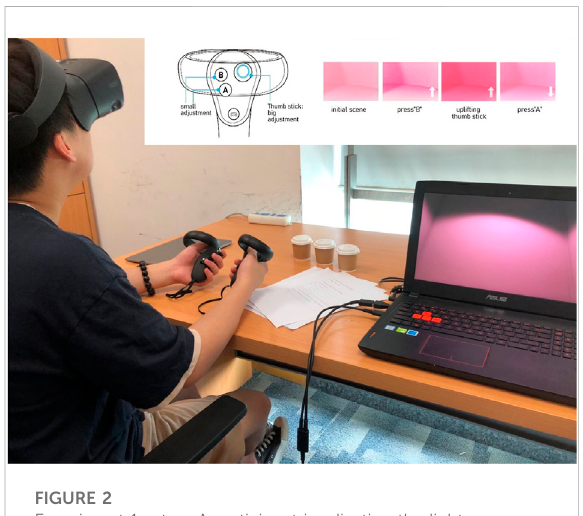
FIGURE 2 Experiment 1 setup. A participant is adjusting the light intensity of pink ambient color in the virtual room displayed via an VR HMD, which is connected to a